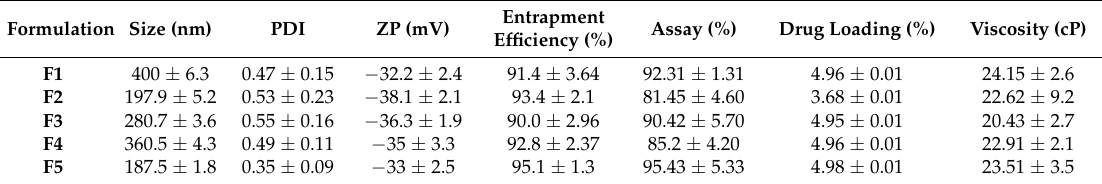
Table 2. Physical characteristics – size, PDI, ZP, assay, drug loading, entrapment efficiency and viscosity of triamcinolone acetonide loaded solid lipid nanoparticles (mean ± SD, n = 3). Formulation Size (nm) PDI ZP (mV)